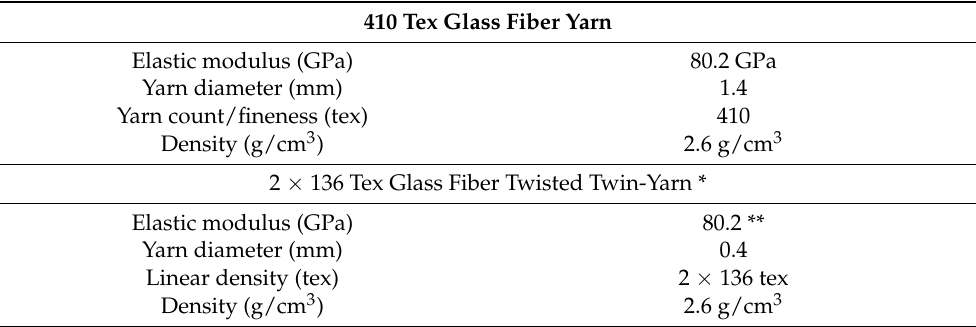
Table 7. Properties of the glass fiber yarns used for the knitted